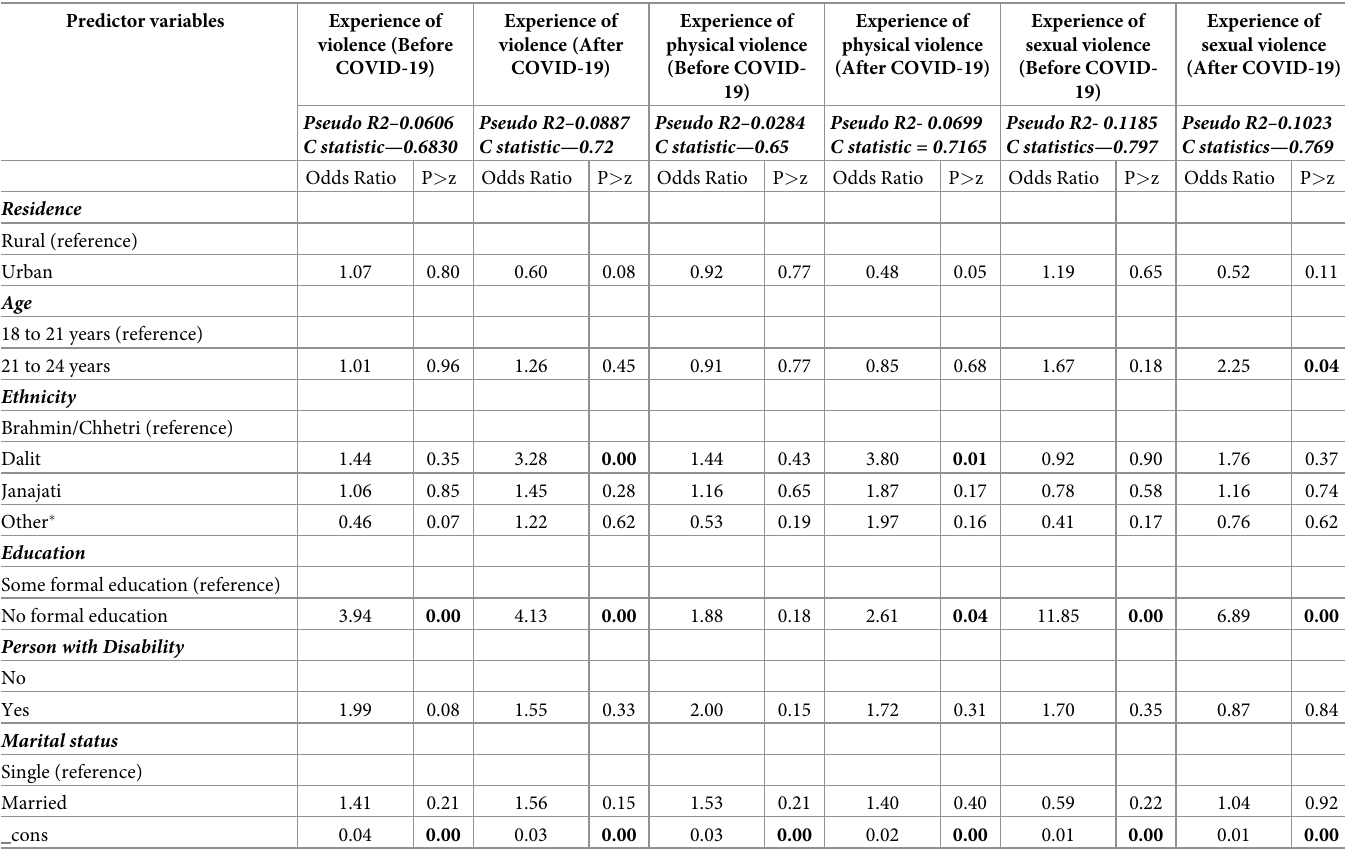
Table 5. Regression models looking at association between predictor socio demographic variables and experience of violence. Predictor